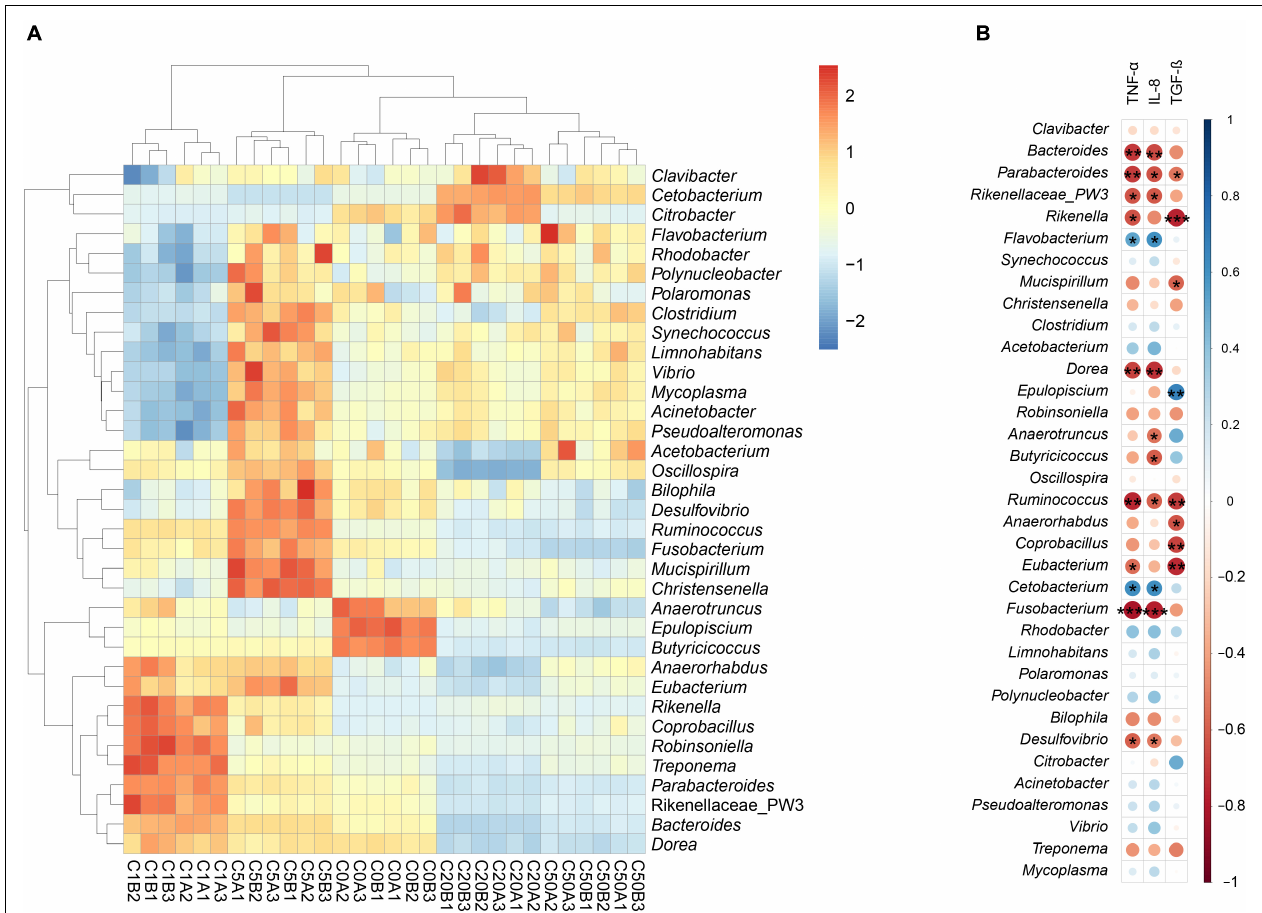
FIGURE 6 | Heatmap profile shows significantly different dominant genera between Xenopus laevis gut microbiota with different environmental MC-LR contents (A) and the correlation of these genera with TNF- α , IL-8, and TGF- β (B) . * p < 0.05; ** p < 0.01; *** p < 0.001.